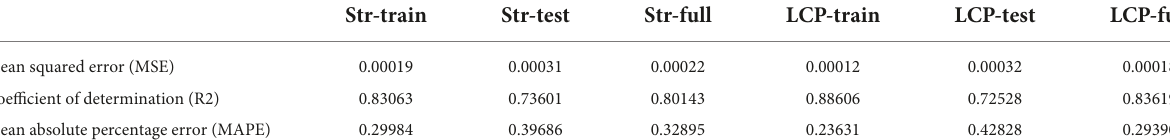
TABLE 2 XGBoost-RFR model performance for train, test, and full sets using straight-line and least cost path methods.